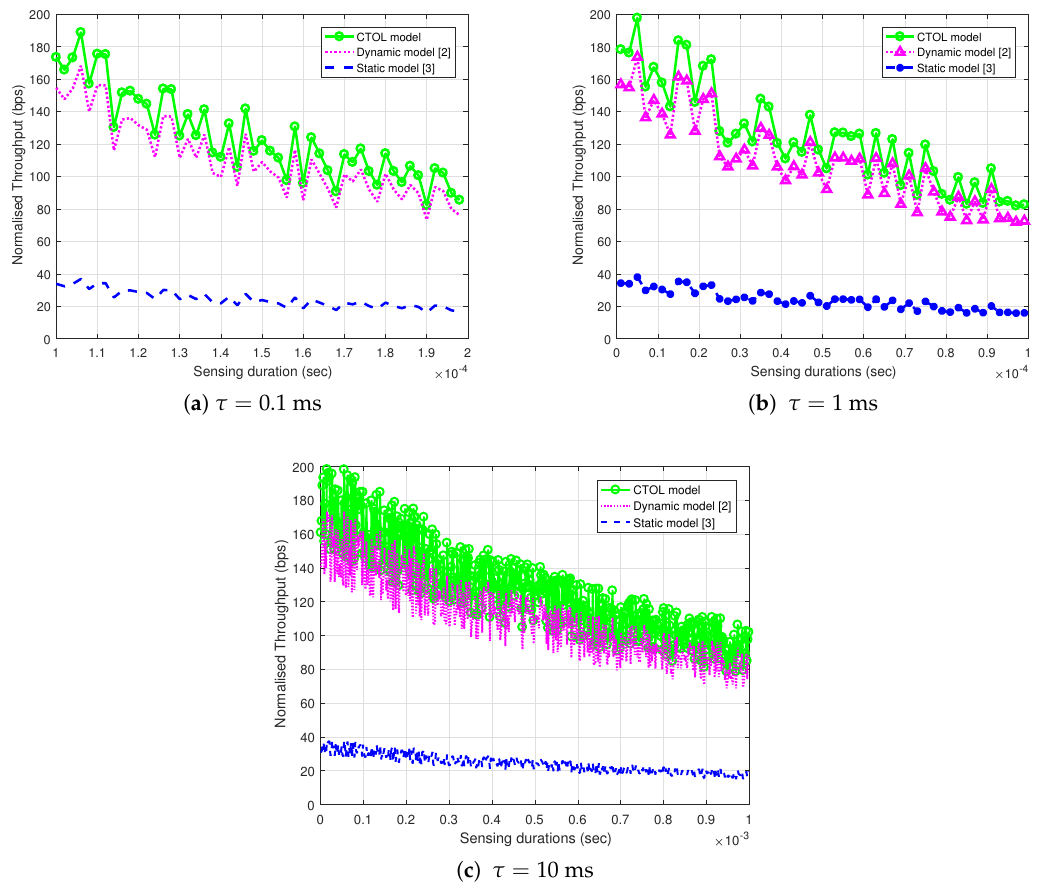
Figure 7. The effect of sensing the duration of the normalized throughput for the secondary user when increasing the sensing time: ( a ) τ = 0.1 ms; ( b ) τ = 1 ms and ( c ) τ = 10